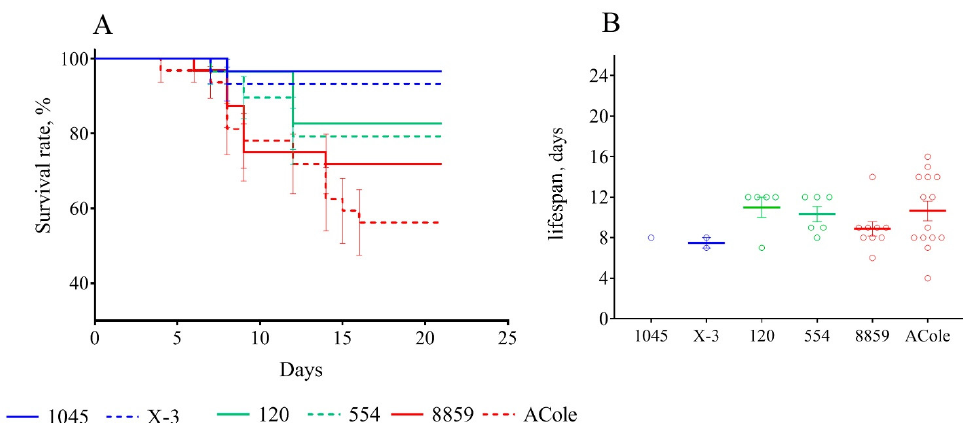
Figure 7. Survival rate ( A ) and lifespan ( B ) of mice immunized 90 days before infection with virulent strains of F. tularensis : subsp. holarctica 1045 and X-3, subsp. mediasiatica 554 and 120, and subsp. tularensis 8859 and ACole. Values are indicated with the standard error of the mean (SEM) for each measurement point.